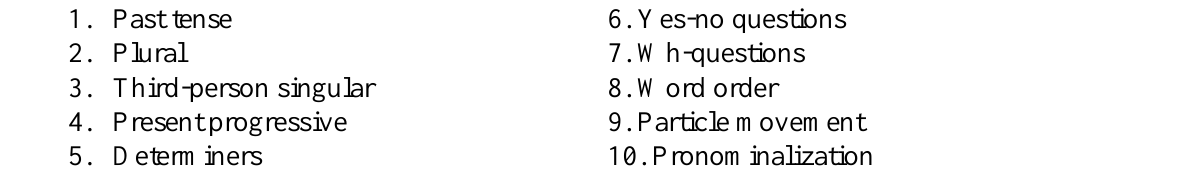
10 Rule Types Tested in Grammaticality Judgment